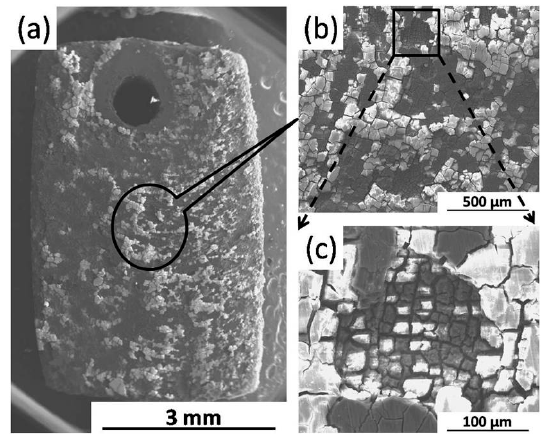
Figure 7. Surface morphology of FSP specimen (at different magnification) after immersion for one day (with corrosion products).